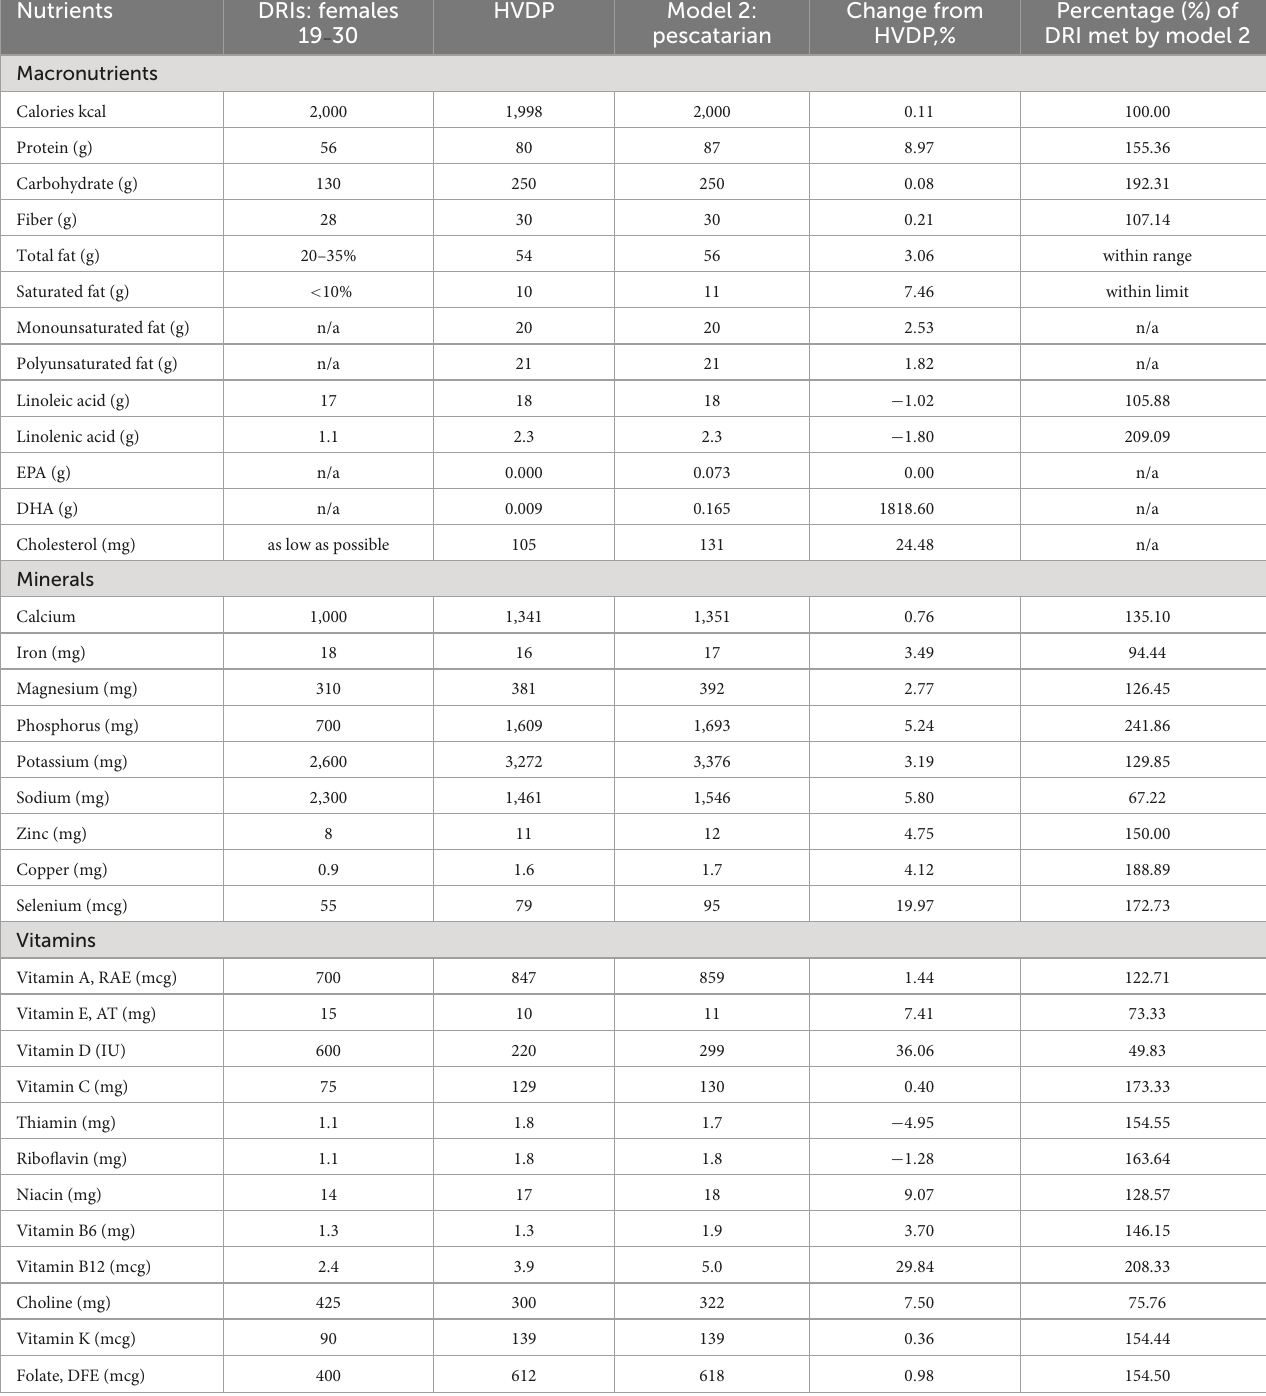
TABLE 5 2,000 kcal pescatarian model of the Healthy Vegetarian Dietary Pattern (HVDP) compared to Dietary Reference Intakes (DRIs) for females 19 – 30